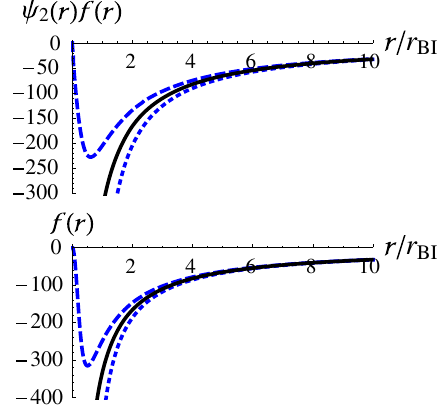
Fig. 1 X ( r ) is shown as a function of r / r BI , where r BI ≡ dashed curve corresponds to an initial condition δ = 0 . 01, i.e., δ > 0, at x i = 10. The dotted curve, on the other hand, corresponds to an initial condition δ = − 0 . 01, i.e., δ < 0. The solution without the mimetic field, i.e., X = 1 is shown by the solid line